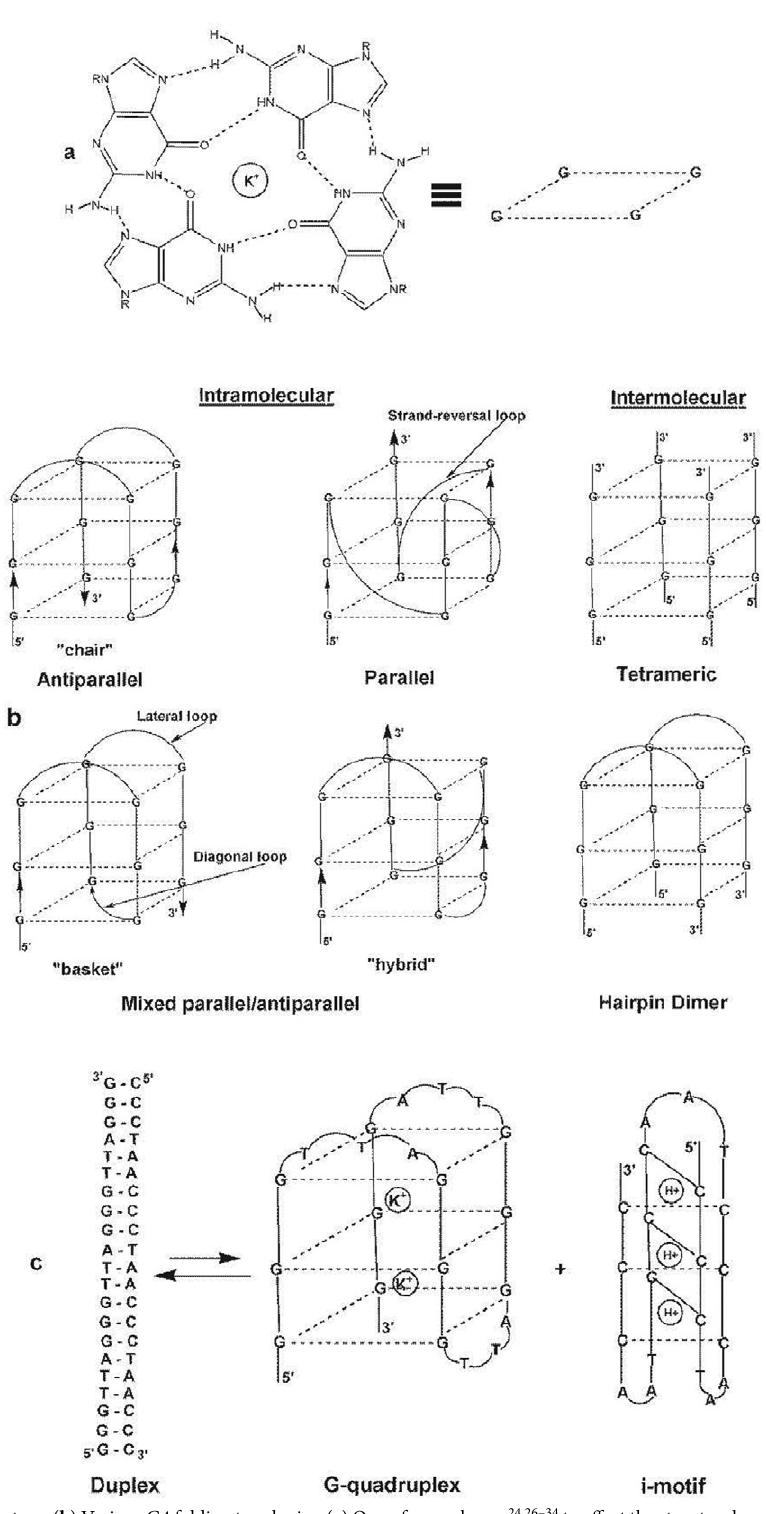
Figure 1. ( a ) G-tetrad structure. ( b ) Various G4 folding topologies. ( c ) One of several ways 24,26–34 to affect the structural equilibrium between duplex and G4/i-motif is by small-molecule binding.